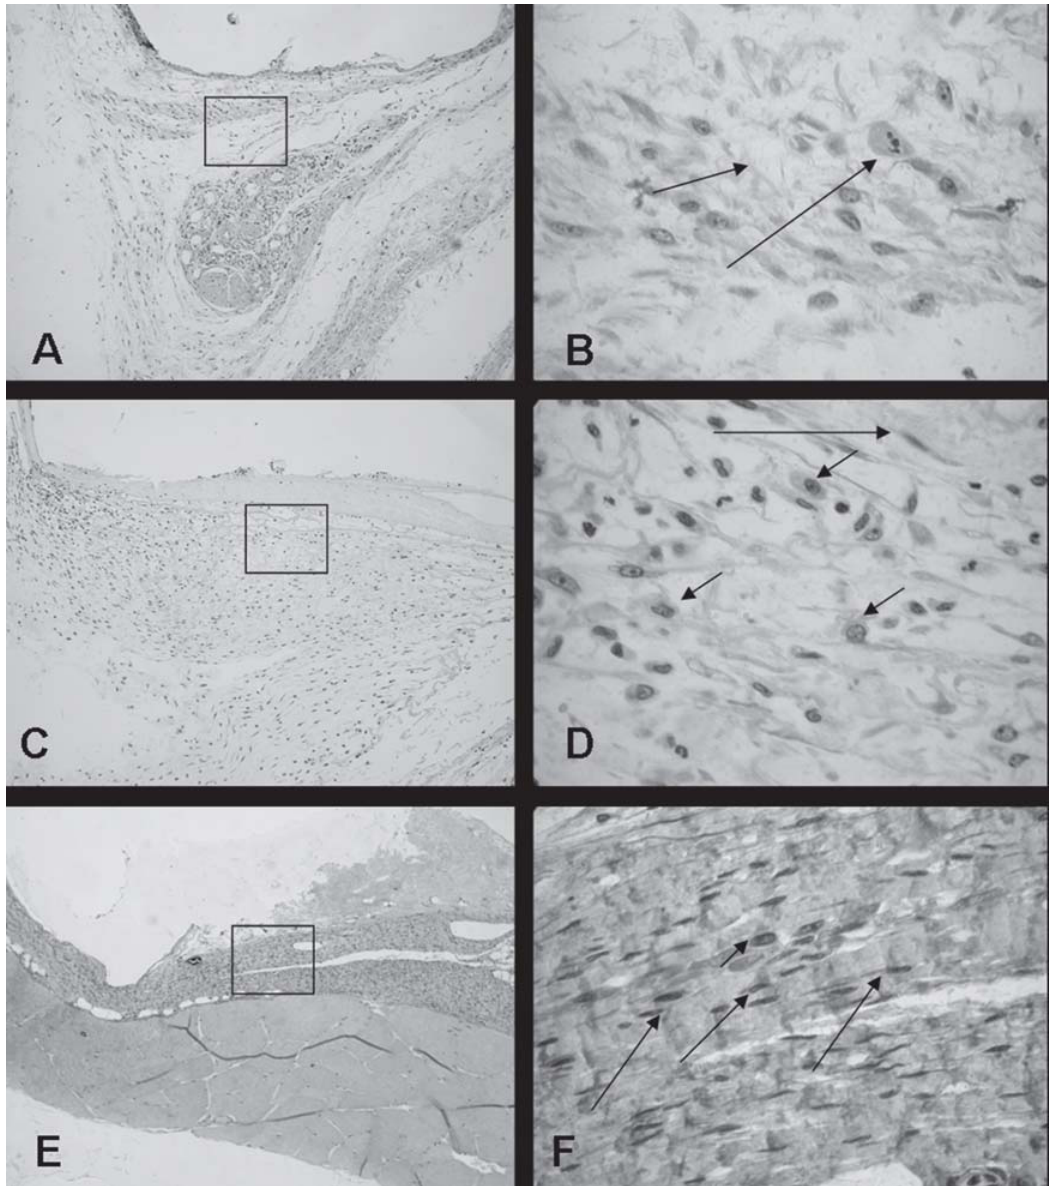
FIGURE 3- Rat subcutaneous tissue reaction to Pulp Canal Sealer EWT. Moderate inflammation was observed on the 3rd day - HE 50x (A). Greater magnification showing the presence of neutrophils (large arrow), macrophages, fibroblasts and few connective fibers (small arrow) - HE 400x (B). The intensity of the inflammatory reaction was attenuated on the 7th day and chronic inflammatory cells were predominant - HE 50x (C). In a greater magnification, it was possible to identify fibroblasts (large arrow), inflammatory cells (small arrows) and connective fibers between the cells - HE 400x (D). On the 30th day, a fibrous capsule was present between the opening tube and the tissue - HE 50x (E). Greater magnification showing remaining chronic cells (small arrow) and fibroblasts (large arrows)- HE 400x